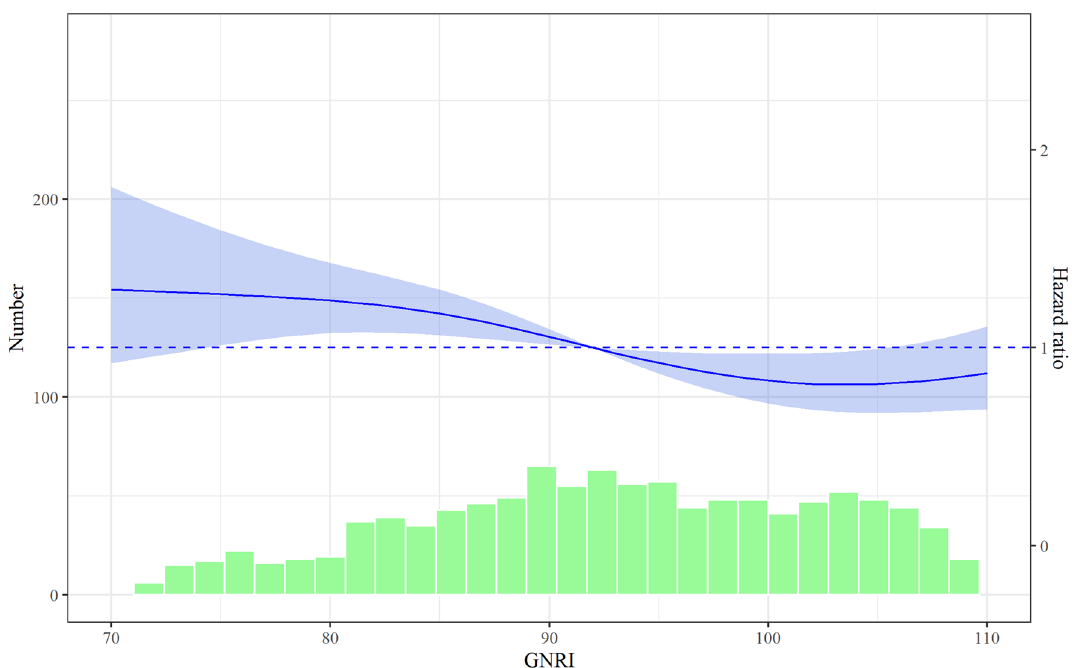
Figure 2. Hazard ratios for the composite outcome (all-cause death and heart failure rehospitalization) according to the Geriatric Nutritional Risk Index score. The blue line represents the continuous hazard ratio (HRs) and the light blue area represents the 95% confidence intervals. The green bars represent the numbers of patients with each Geriatric Nutritional Risk Index (GNRI) score.